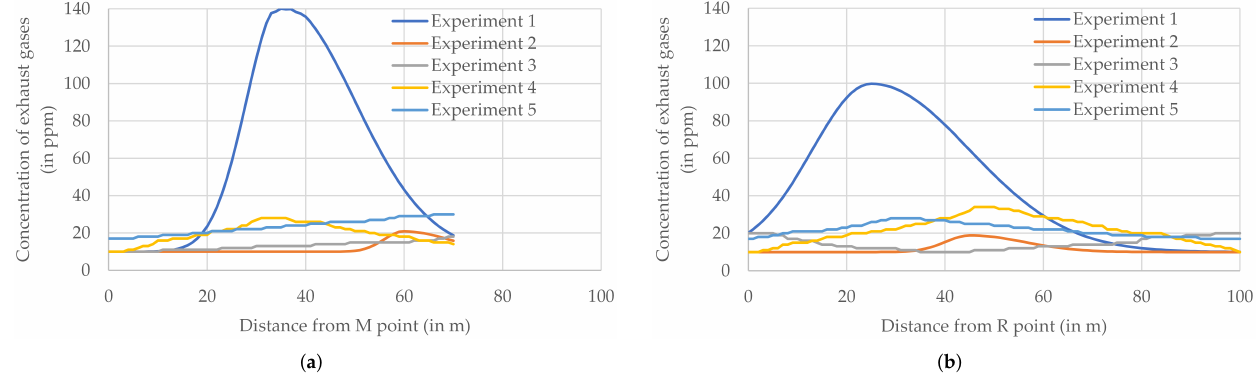
Figure 10. Concentration of exhaust gases (in ppm) measured at fixed points in selected sections of the flight route: ( a ) M-N; ( b )